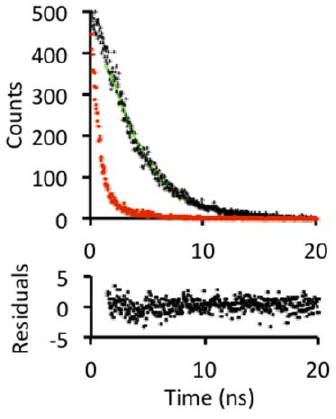
Figure 6. Fluorescence lifetime analysis of EGFP. Photon counts (black dots) measured over 20 ns were fit to a single exponential decay function (green line) with the instrument response function shown as red dots. Residuals for the single exponential decay fit to the data are plotted below the decay curve.